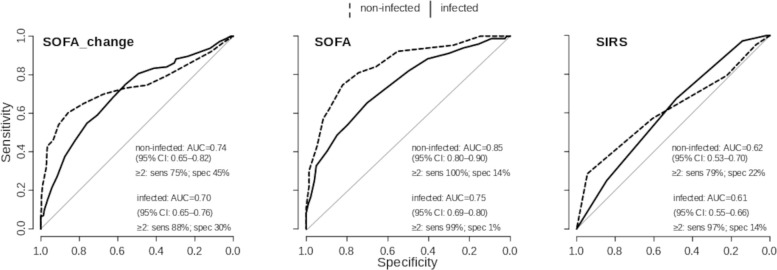
Receiver Operating Characteristic (ROC) curves for Sequential Organ Failure Assessment (SOFA) score applications and Systemic Inflammatory Response Syndrome (SIRS) criteria discrimination for in-hospital mortality in infected (n = 369) and non-infected (n = 422) patients.Discrimination capacity of SOFA for in-hospital mortality was significantly stronger in non-infected than in infected patients (p = 0.006). SIRS discriminated for in-hospital mortality in both subgroups with lower AUC compared to SOFA applications. If applied with the proposed threshold, SOFA≥2 was more sensitive and less specific for in-hospital mortality than SIRS≥2. AUC: Area Under the Curve; SIRS: Systemic Inflammatory Response Syndrome; SOFA: Sequential Organ Failure Assessment; sens: sensitivity; spec: specificity.